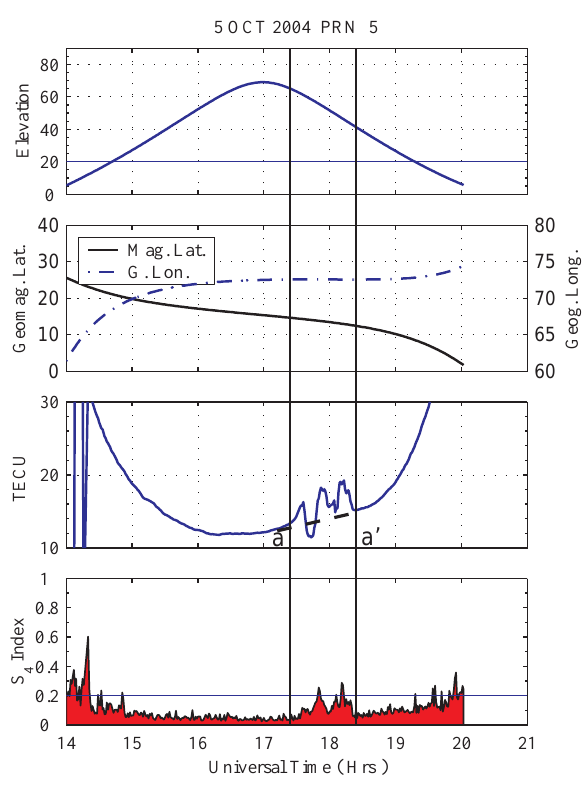
Fig. 6. Observation of consecutive enhancements and depletions in TEC on 5 October 2004 for PRN 5. Very weak scintillations are associated with these features. The rest of the labels are the same as in Fig.